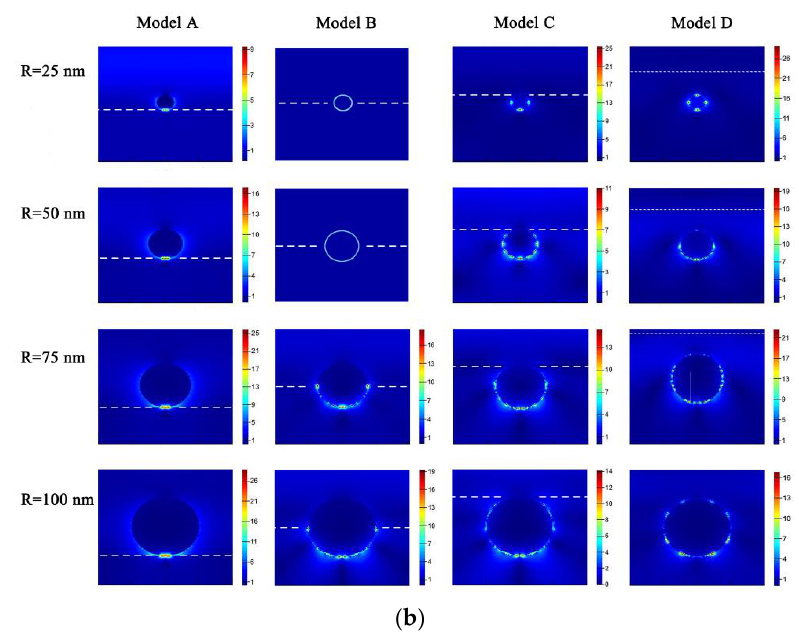
Figure 4. The distribution of the local enhanced electric field of Au nanospheres on a TiO 2 substrate induced by different wavelengths: ( a ) LSPR absorption peaks; and ( b ) interband transition peaks. The dashed line represents the interface between the Au nanospheres and the TiO 2 substrate.